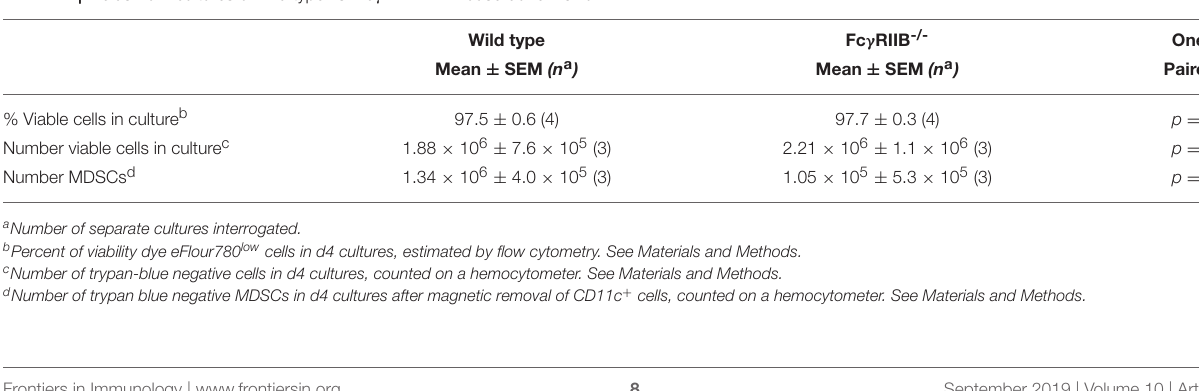
TABLE 1 | Yields from cultures of wild type vs. Fc γ RIIB − / − mouse bone marrow.